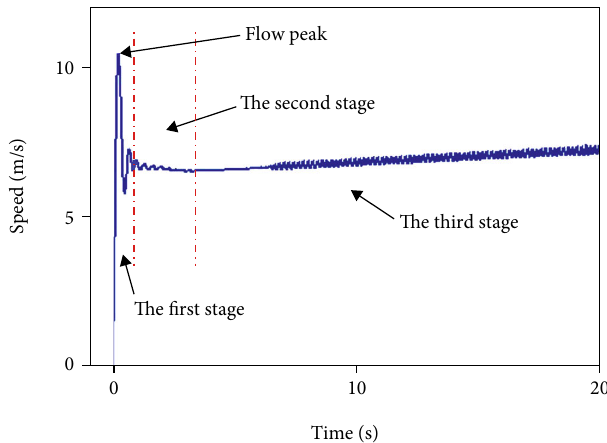
Figure 2: Three-stage characteristics of transient coupled fl ow in matrix-fracture.